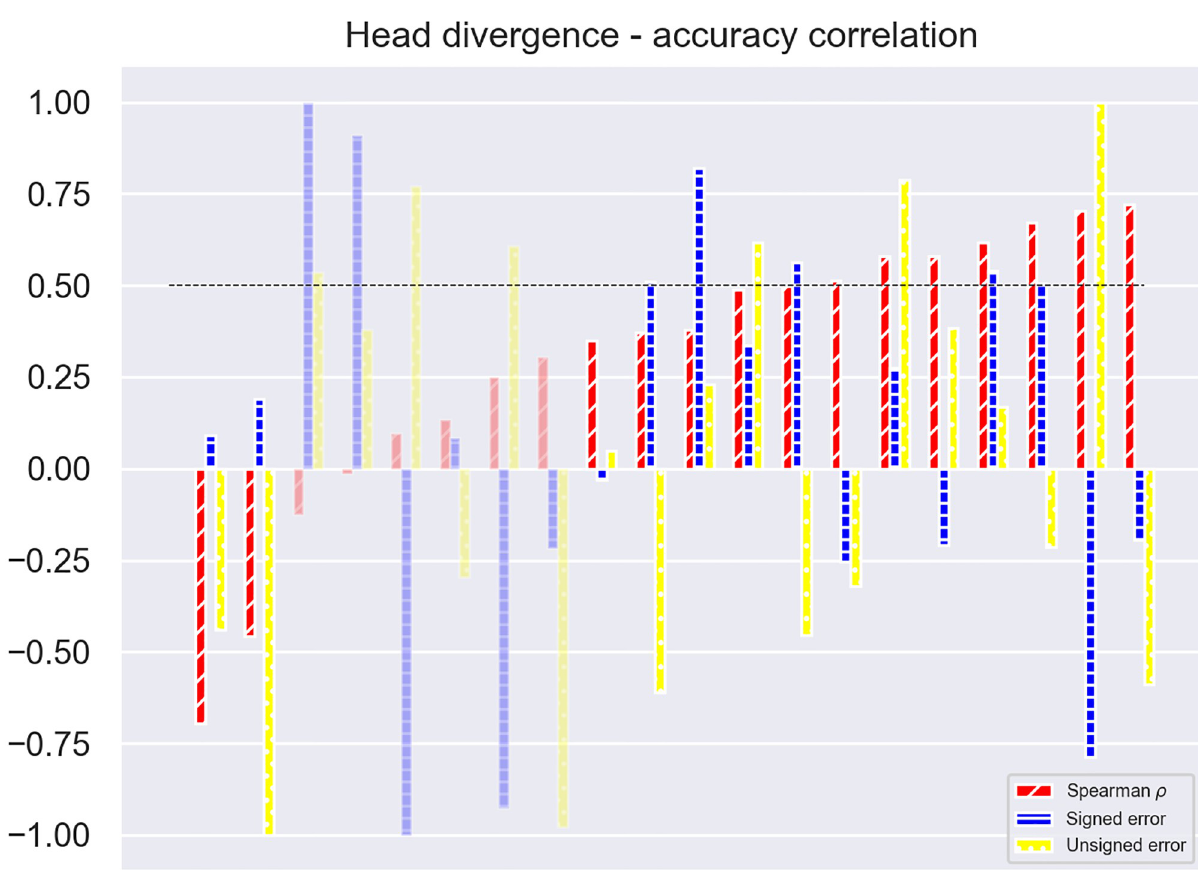
Fig 6. Spearman’s ρ correlation values (red) for each participant belonging to group G ( V ) in V condition, in ascending order, together with their respective means of the signed (green) and unsigned (blue) errors, normalized in the interval [-1, 1]. The opaque bars are the one with statistically significant correlations, while the transparent ones have p -values �